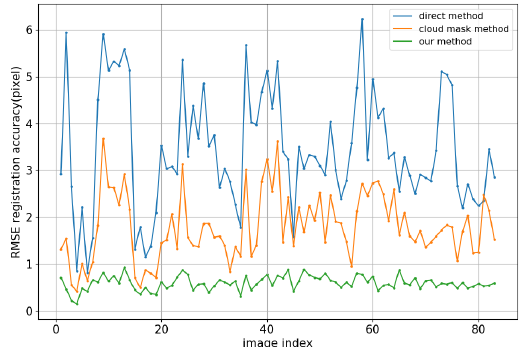
Figure 9. Color composite images of our methods in cloudy images. (a), (b) are true-color images with band 2,7,14. (c), (d) are pseudocolor images with band 2,7,21.